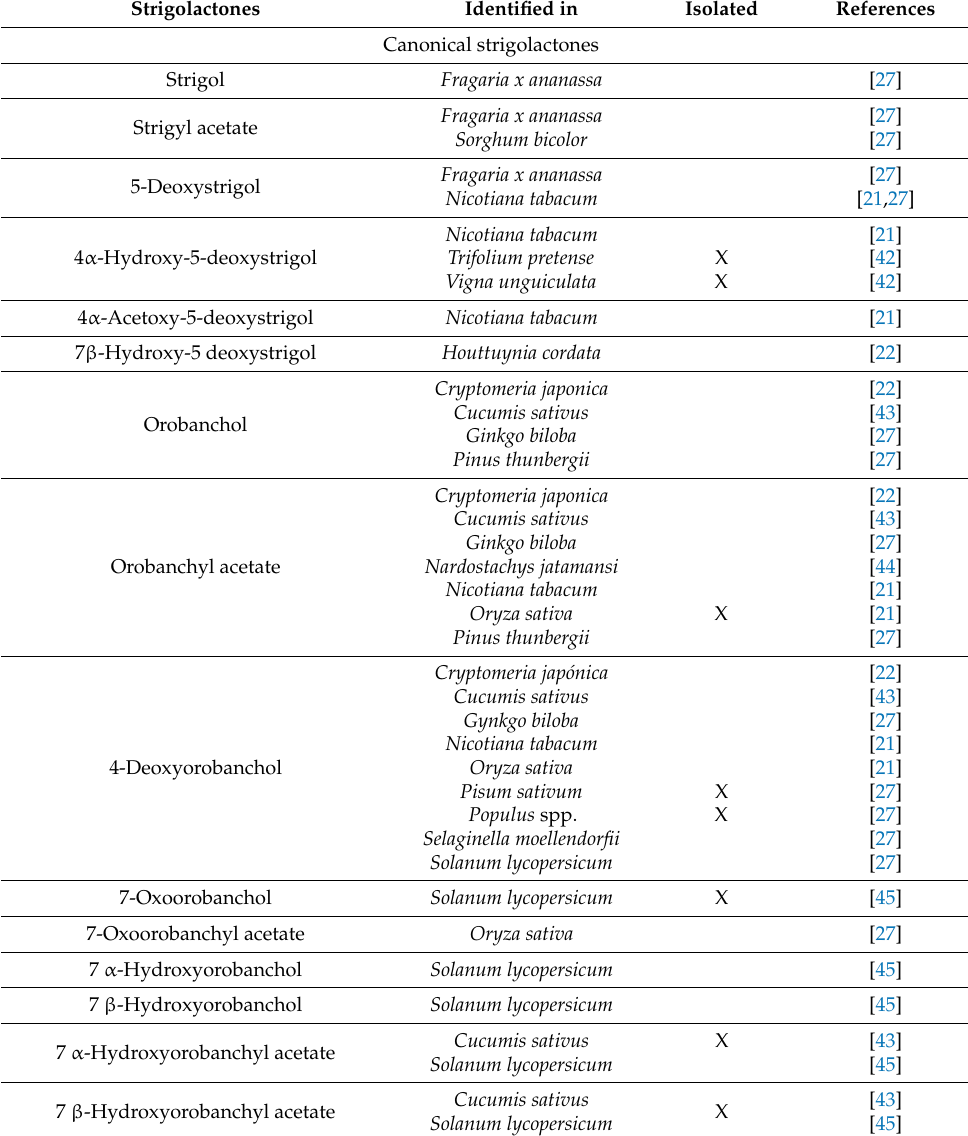
Table 1. Extension and update on the strigolactones identified since the review by ´Cavar et al. (2015) [6]. Strigolactones isolated are